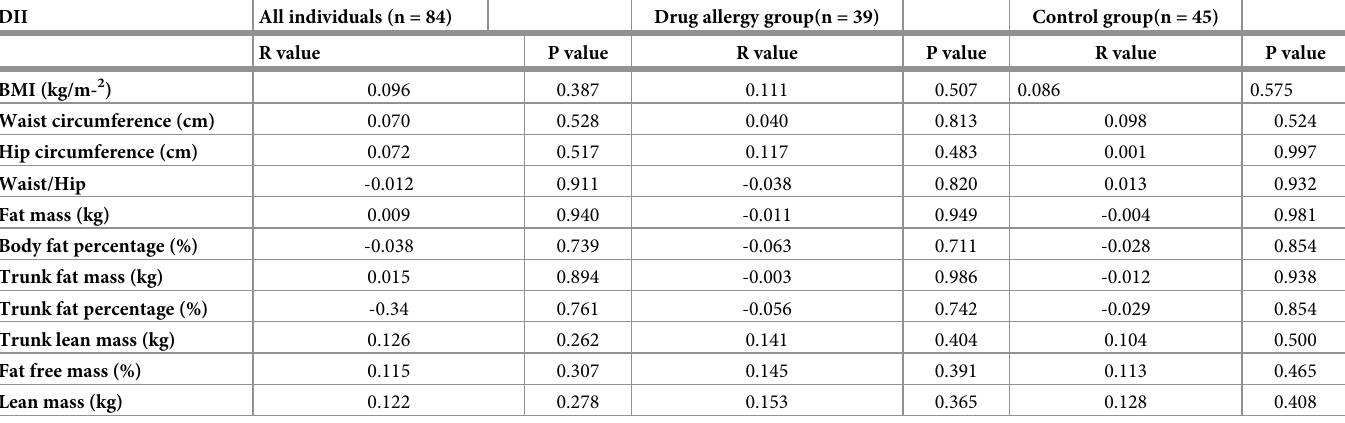
Table 2. Correlations between DII and anthropometric/bioimpedance parameters.